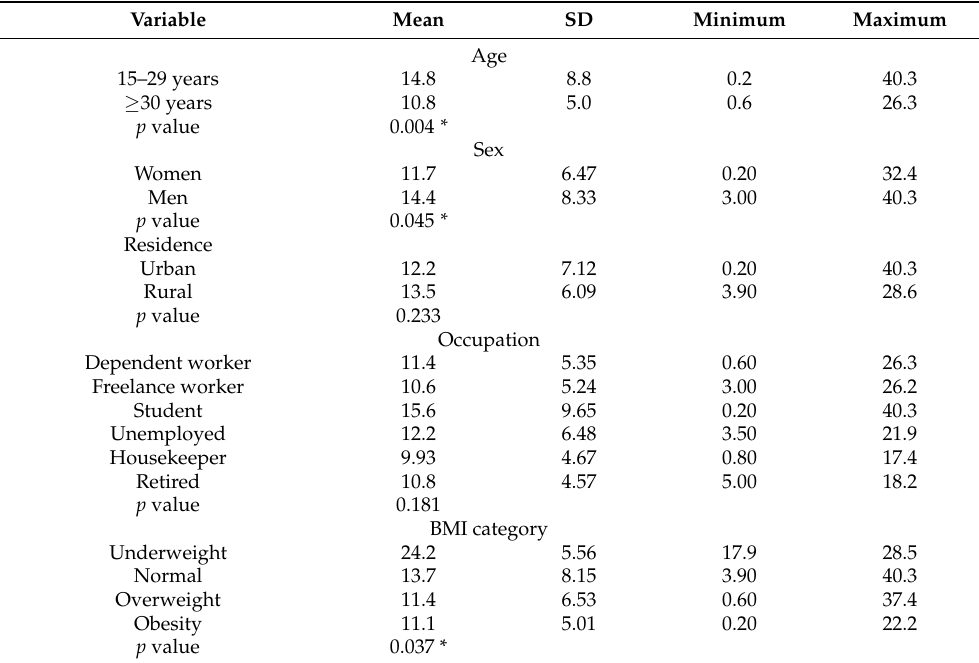
Table 3. Description of total fiber intake (g/day) ( n = 196).